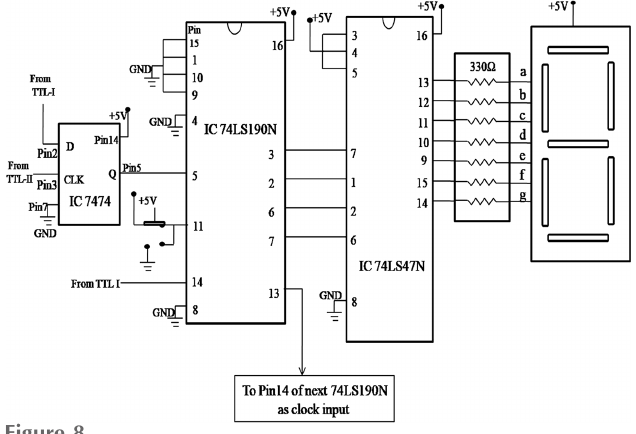
Figure 8 Circuit diagram of the counter with seven-segment